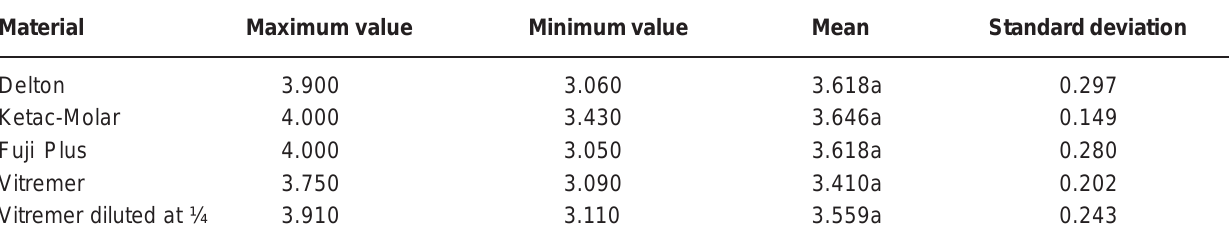
TABLE 2- Maximum and minimum values, means and standard deviations achieved by the Kruskal-Wallis test for analysis of depth of penetration of the sealant into pits and fissures